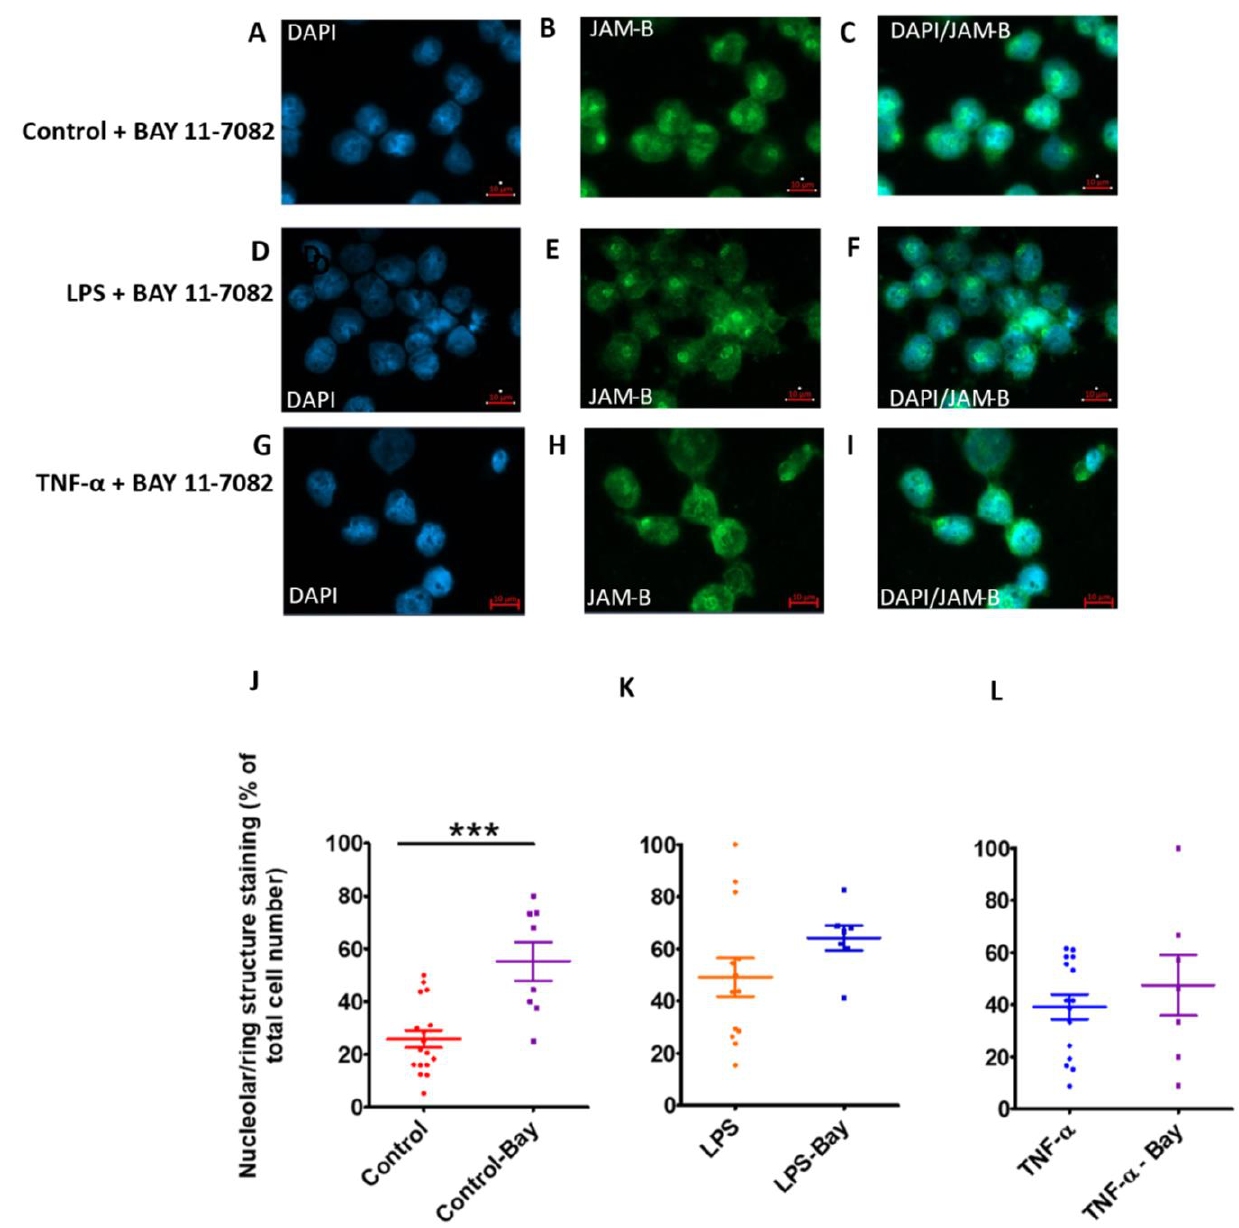
Figure 8. The effects of the NF-κB inhibitor Bay-11-7082 (10 µM) after 24 h treatment on JAM-B subcellular localisation in THP-1-differentiated macrophages. ( A – C ) DAPI, JAM-B and composite image in control-treated samples; ( D – F ) DAPI, JAM-B and composite image in LPS-treated samples; ( G – I ) DAPI, JAM-B and composite image in TNF-α-treated samples. ( J ) JAM-B punctate